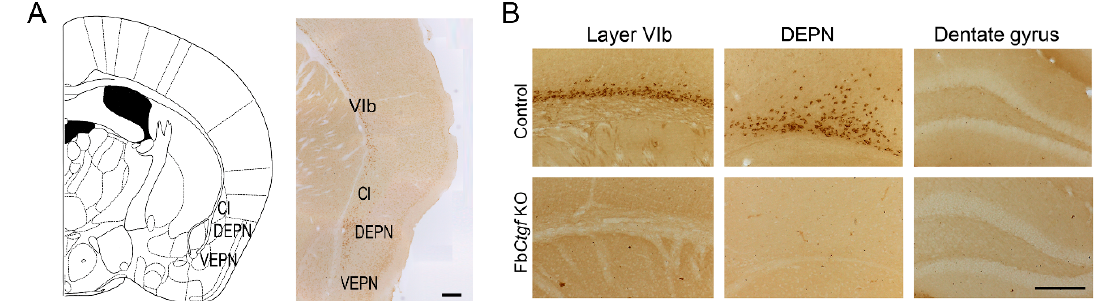
Figure 1. Connective tissue growth factor (Ctgf) protein is expressed in distinct regions of the brain such as the cortical layer VIb, dorsal claustrum and dorsal endopiriform nucleus (DEPN), but not in the ventral claustrum (Cl) or ventral endopiriform nucleus (VEPN) ( A ). The native expression of Ctgf protein was abolished in forebrain-specific Ctgf knockout (Fb Ctgf KO) mice ( B ). Both bars = 200 µ m.